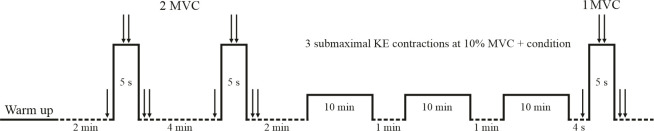
Illustration of the experimental protocol.MVC: maximal voluntary contraction; 1 arrow: single electrical stimulus; 2 arrows: doublet stimulation (10 ms between 2 electrical stimuli); condition: with vibration or without vibration; dotted line: rest period.